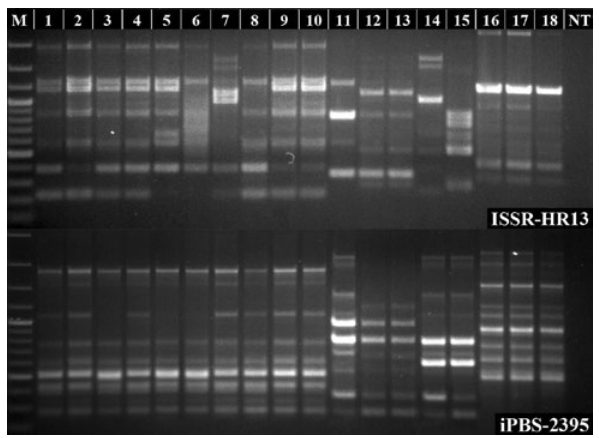
Figure 2. The representative of reproducible gel profiles with ISSR- HR13 and iPBS2395 primers. Lanes 1-10, Bipolaris sorokiniana ; lanes 11-15, Curvularia spicifera ; lanes 16-18, Curvularia inaequalis . Lane M is the DNA marker GeneRuler 100 bp plus (Thermo Scientific).